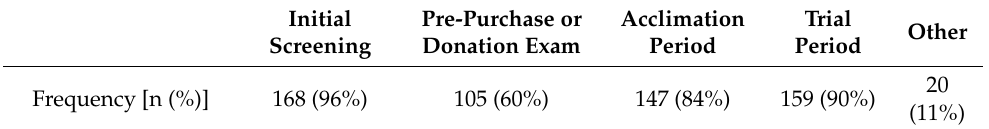
Table 4. Procedures used in selecting horses and ponies.